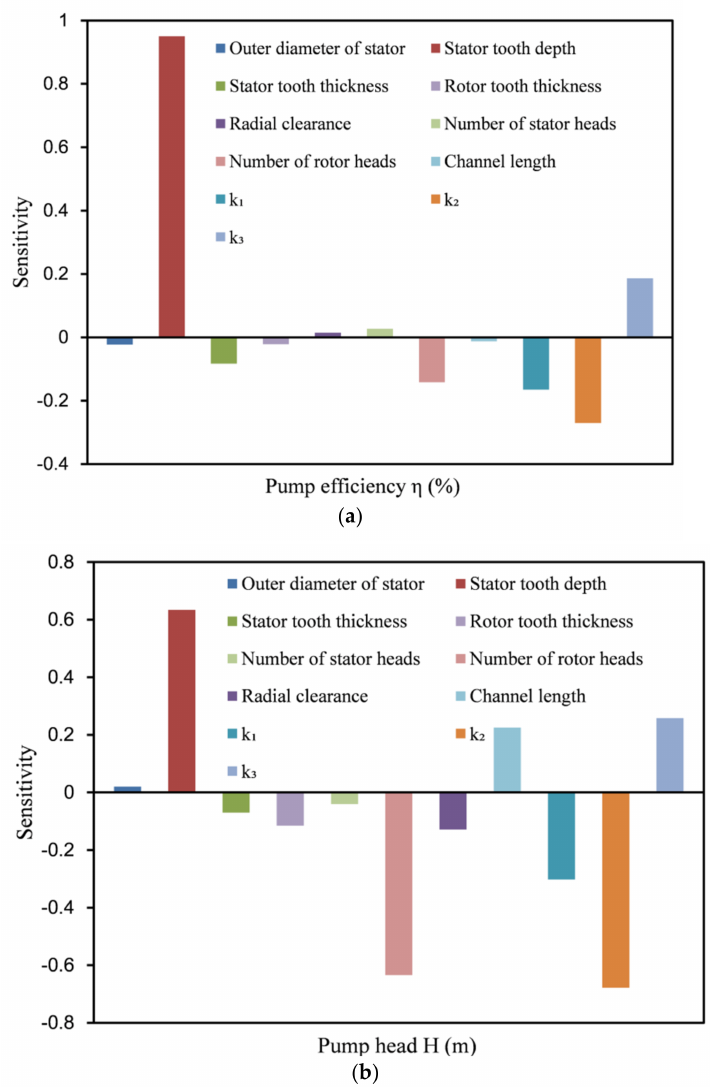
Figure 15. Sensitivity analysis results of design parameters for the ( a ) labyrinth pump head and ( b )